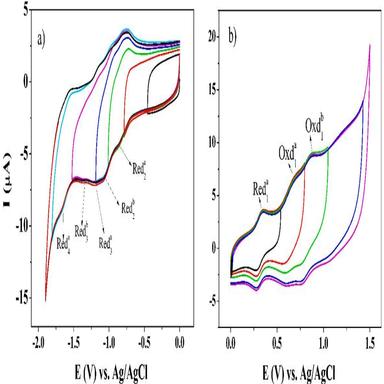
CV and SWVs of (5.0 × 10− 4 mol dm− 3 ) LuPc2 in the electrolyte system of TBAP/DCM on GCE as the working electrode along with differing potentials of vertex potentials at 0.100 Vs− 1 scan rate.